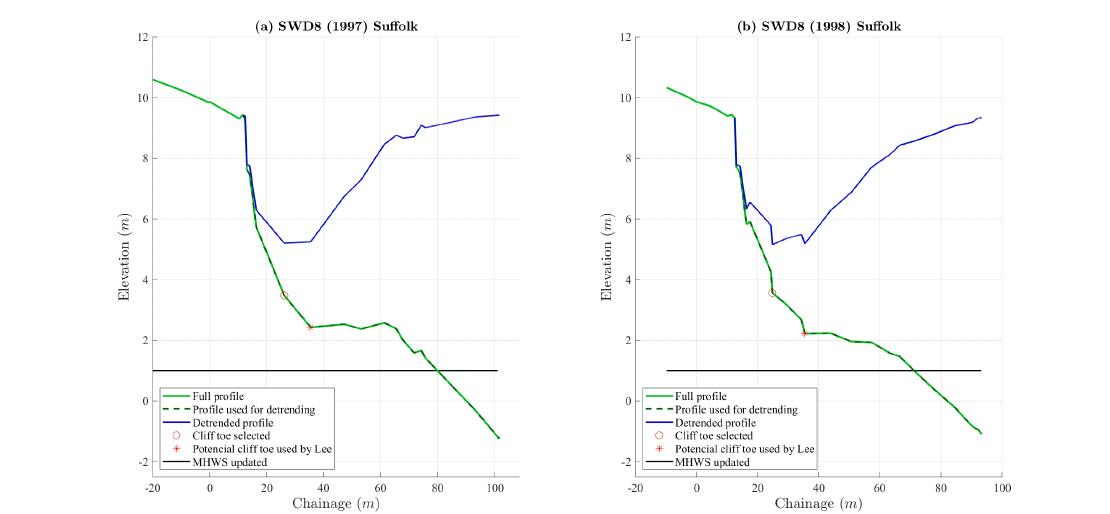
Figure A3. Examples of two outliers found in the BWA scatter plot for Suffolk, SWD8. The full profile, the extracted one used for detrending, the detrended profile obtained for extracting the cliff toe, and the updated MHWS are plotted. The cliff toe selected by applying our method is represented by a red circle, and the potential cliff toe used by Lee with an asterisk. The differences between our selected cliff toe and the potential one used by Lee are enough to obtaining significant differences in the BWA.